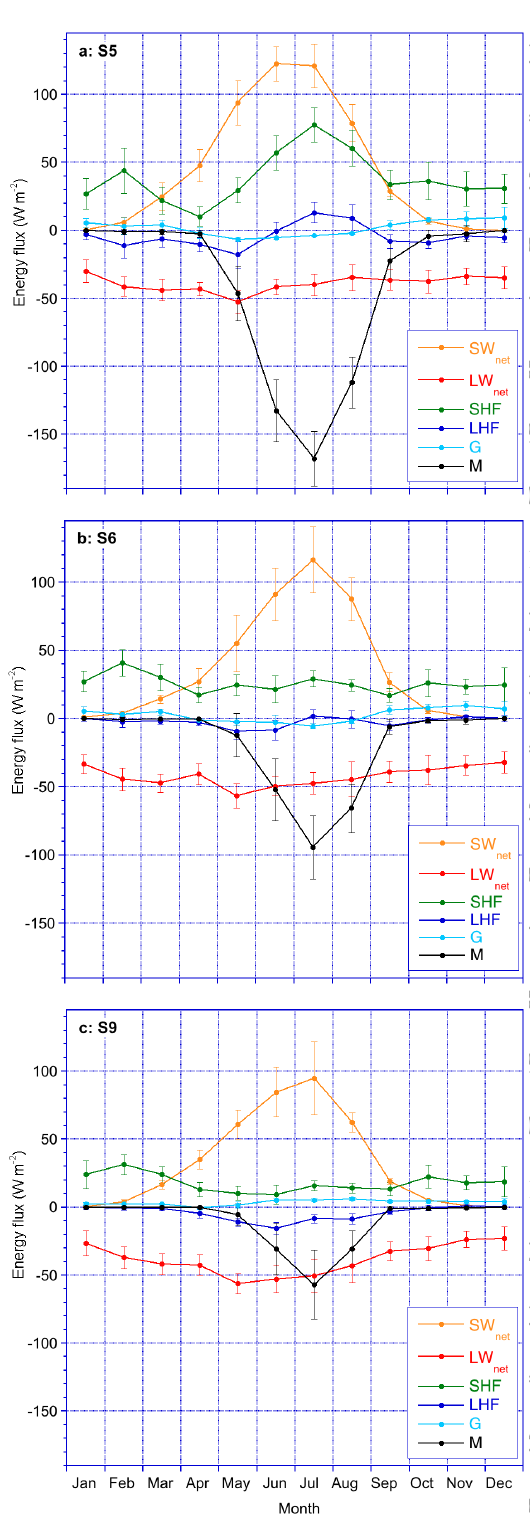
Fig. 7. Average seasonal cycle of SEB components at S5 (a) , S6 (b) and S9 (c) . Error bars indicate standard deviation for the 7-yr pe-